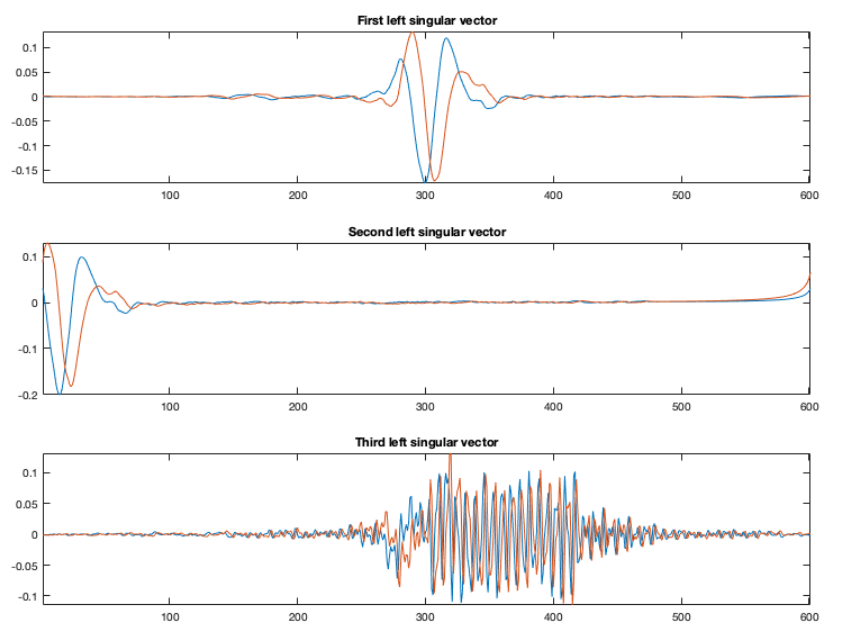
Figure 5. The first, second and third left singular vectors obtained by the SVD decomposition of a generic DLBM.